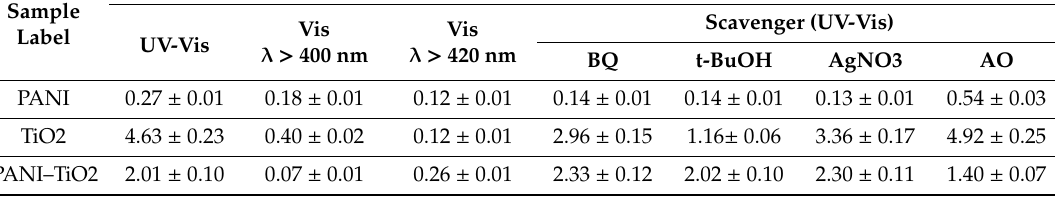
Table 2. Photocatalytic activity in a reaction of phenol degradation (Irradiation time: 60